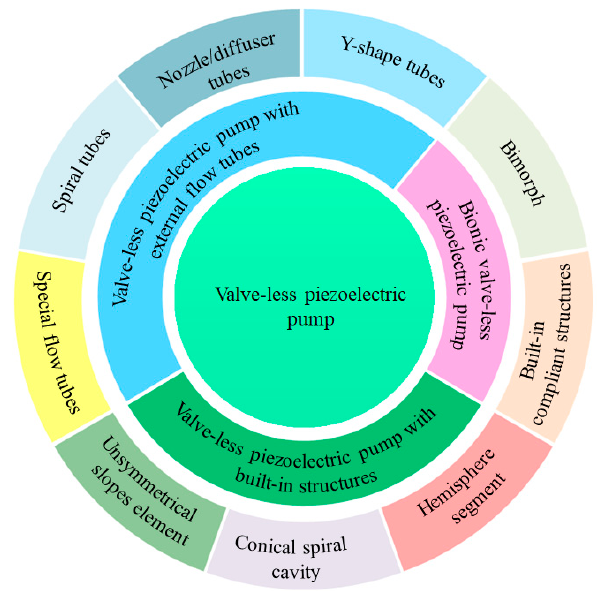
Figure 1. Classification of valveless piezoelectric pumps.